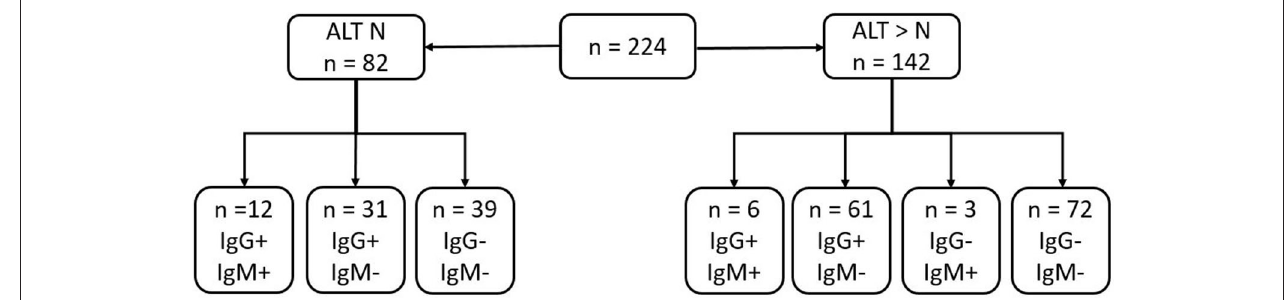
FIGURE 1 | Summary of serological results of samples depending on ALT results (N, normal value: N < 35 U/L in our lab).